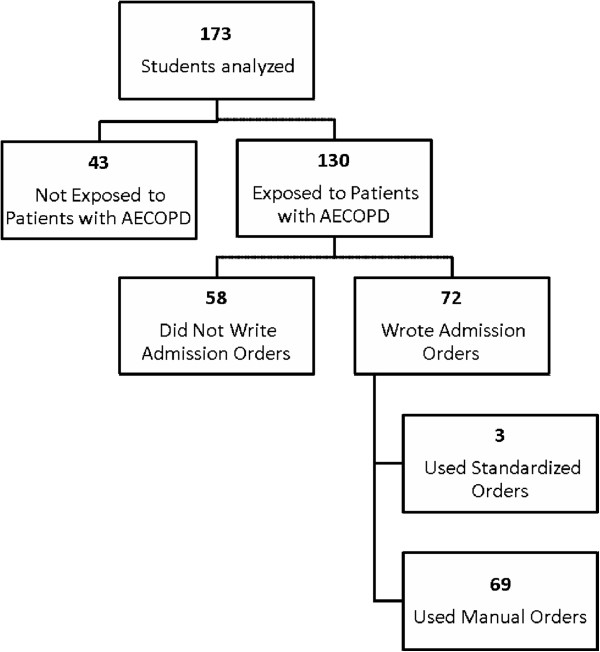
Flow sheet of students analyzed, exposed to AECOPD, wrote admission orders and exposed to standardized doctor’s orders for AECOPD.